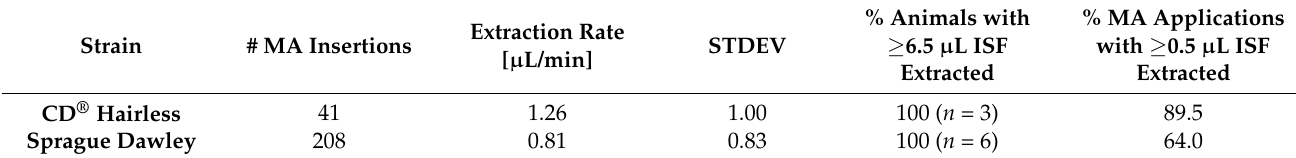
Table 1. Characteristics of ISF extractions.